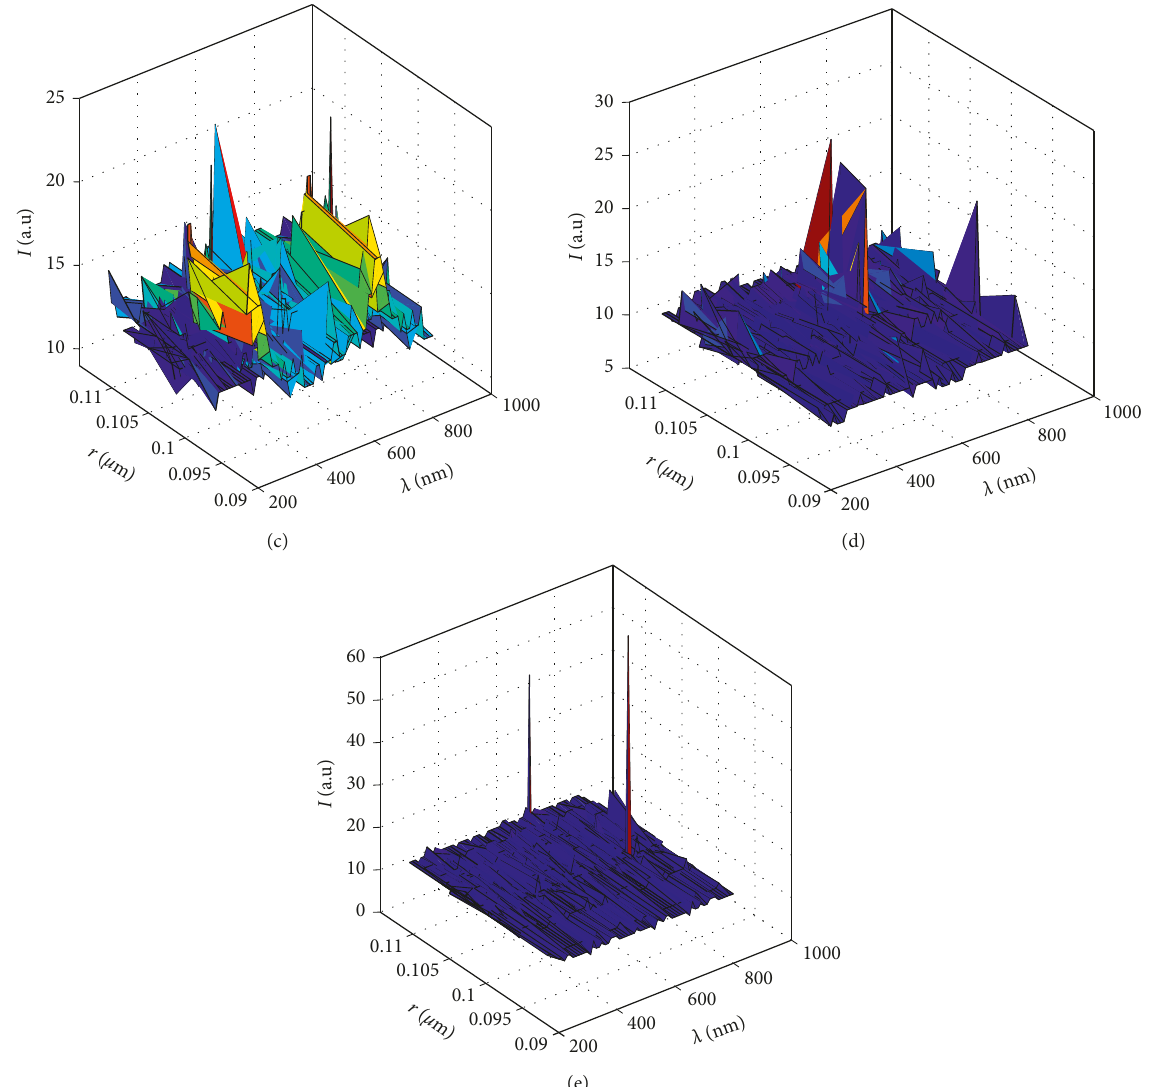
Figure 3: Three dimensional plots of pixel intensities/a.u (represented as I ) and radii/ μ m (represented as r ) against spectral range/nm (represented as λ ) of multispectral images in the reflection mode for (a) uninfected RBCs ( u -RBCs) and Plasmodium falciparum -infected RBCs ( i -RBCs) of parasite density (PD) (b) (+), (c) (++), (d) (+++), and (e)